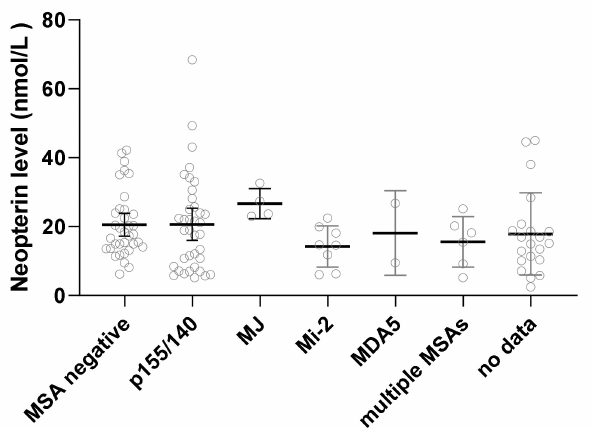
Figure 1. Myositis-specific antibodies and neopterin level. The serum neopterin level varied slightly based on the various MSA (myositis-specific antibodies) groups; however, the difference was not statistically significant by one way ANOVA test. The anti-MJ (Anti-NXP-2) group had the highest mean neopterin at 24.8 +/ − 8.1 SD nmol/L, and the Mi2 group had the lowest level at 14.7 +/ − 5.50 SD